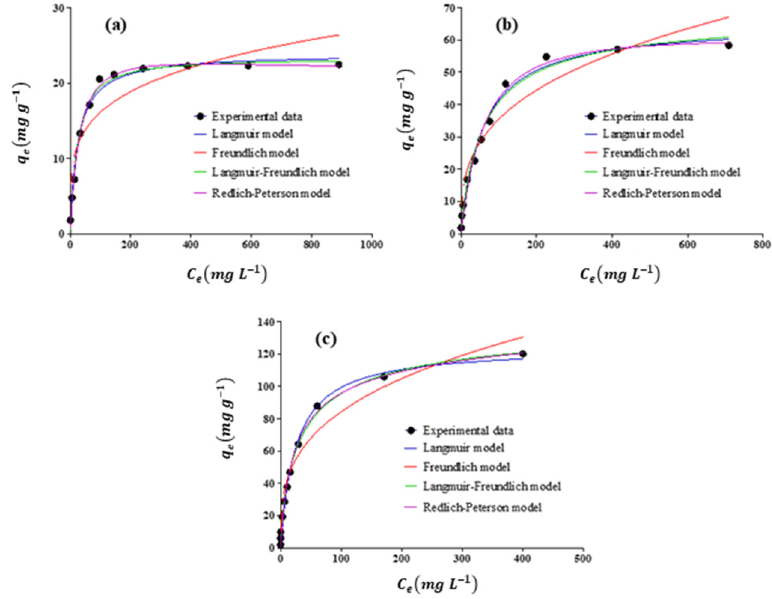
Figure 10. Adsorption isotherm plots for the removal of Pb(II) by ( a ) RS, ( b ) RSAC, and ( c ) nZVFe–RSAC. Table 5. Adsorption Parameters of Langmuir, Freundlich, Langmuir–Freundlich, and Redlich– Peterson models for Pb(II) adsorption on varied